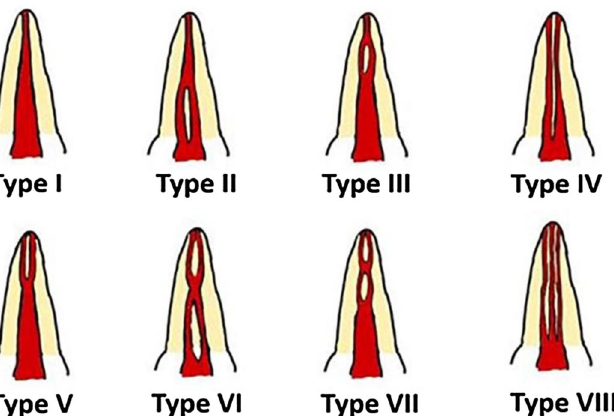
Figure 1. Classification of root canal configuration. Type I; a single canal extends from the pulp chamber to the apex. Type II; two separate canals leave the pulp chamber and join short of the apex to form one canal. Type III; one canal leaves the pulp chamber, divides into two within the root, and then merges to exit as one canal. Type IV; two separate and distinct canals extend from the pulp chamber to the apex. Type V; one canal leaves the pulp chamber and divides short of the apex into two separate and distinct canals with separate apical foramina. Type VI; two separate canals leave the pulp chamber, merge in the body of the root, and re-divide short of the apex to exit as two distinct canals. Type VII; one canal leaves the pulp chamber, divides and then rejoins within the body of the root, and finally re-divides into two distinct canals short of the apex. Type VIII; three separate and distinct canals extend from the pulp chamber to the